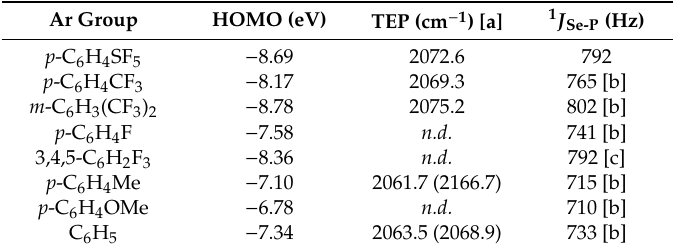
Table 2. Calculated HOMO energies and TEP values of triarylphosphines (PAr 3 ) and experimental 77 Se NMR data of the corresponding